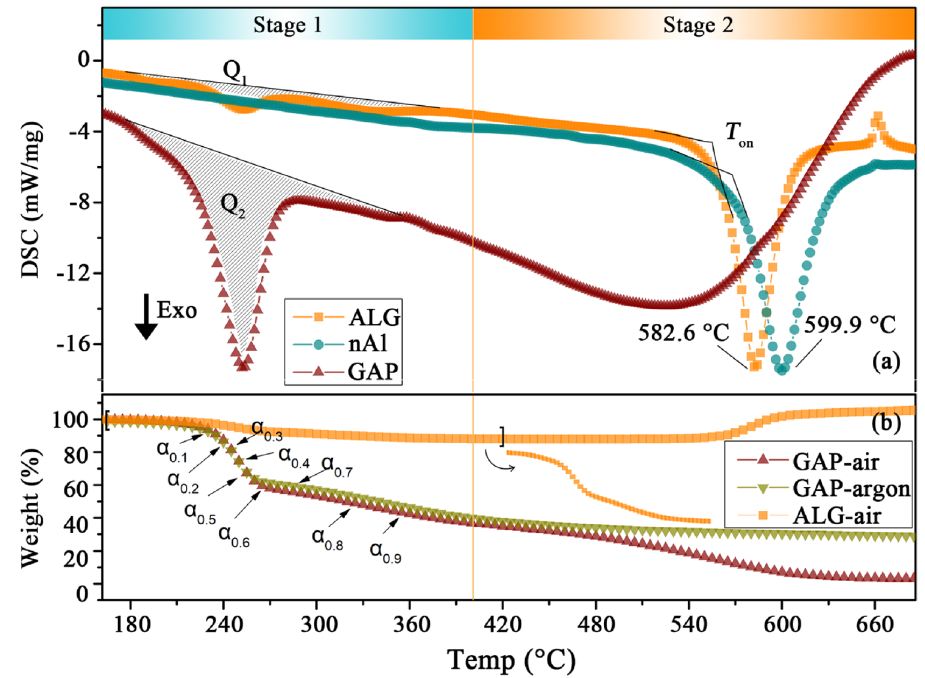
Figure 2. DSC thermographs of samples in air atmosphere at heating rate of 10 °C min −1 ( a ), TGA thermographs of GAP in air and argon atmosphere, and of ALG in air atmosphere at heating rate of 10 °C min −1 ( b ).